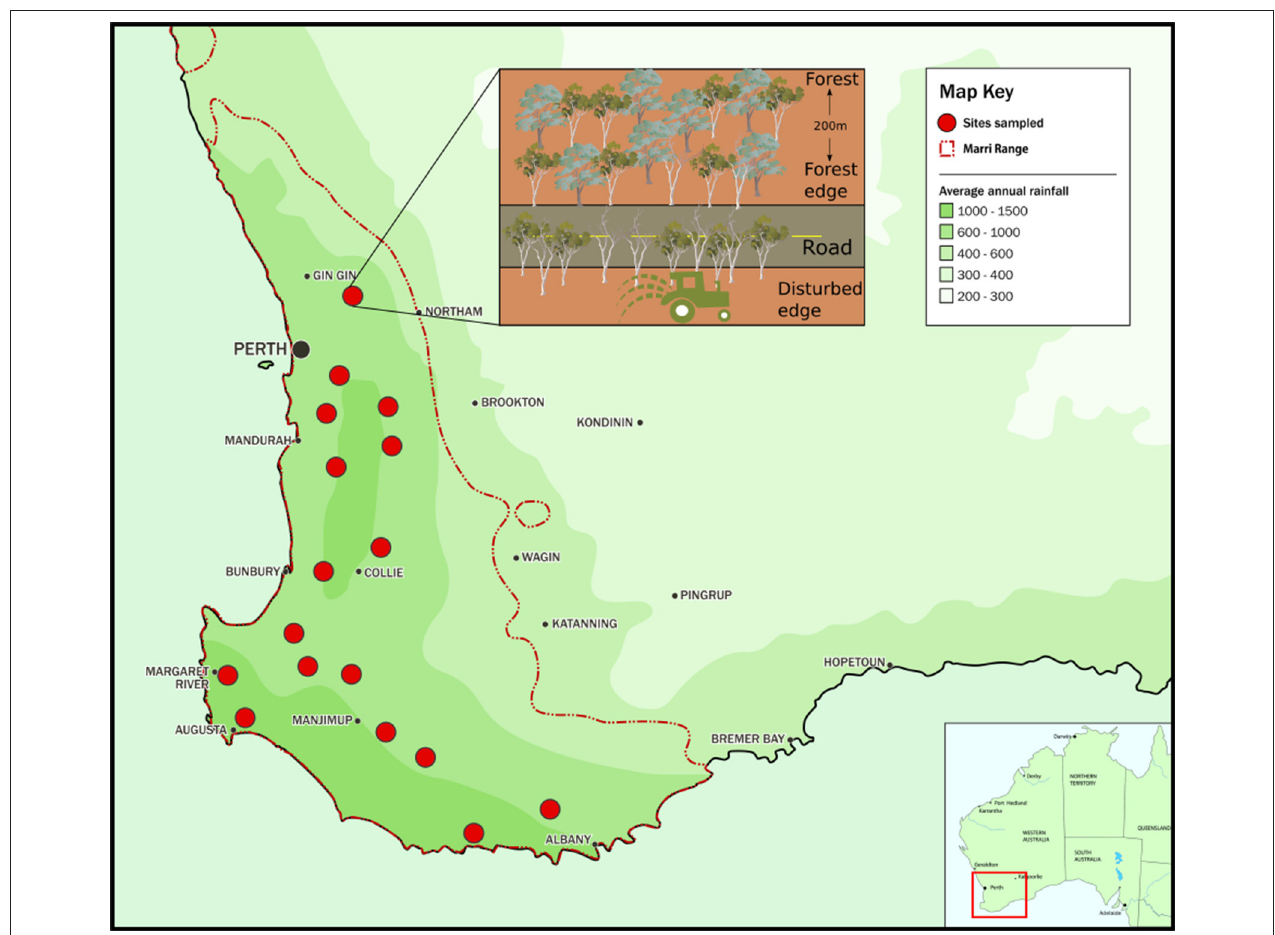
FIGURE 1 | Map of the distribution range of Corymbia calophylla in southwest Western Australia and the 17 study sites. Inset: Each site consisted of three lateral transects perpendicular to the disturbance gradient. The disturbed edge consisted of a remnant stand of C. calophylla bordering agricultural land and a road; the forest edge was adjacent to the road; and the intact forest block was 200m into intact